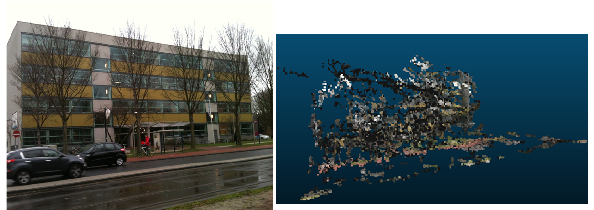
Figure 6: FARO Photon 120/20 model scanner.